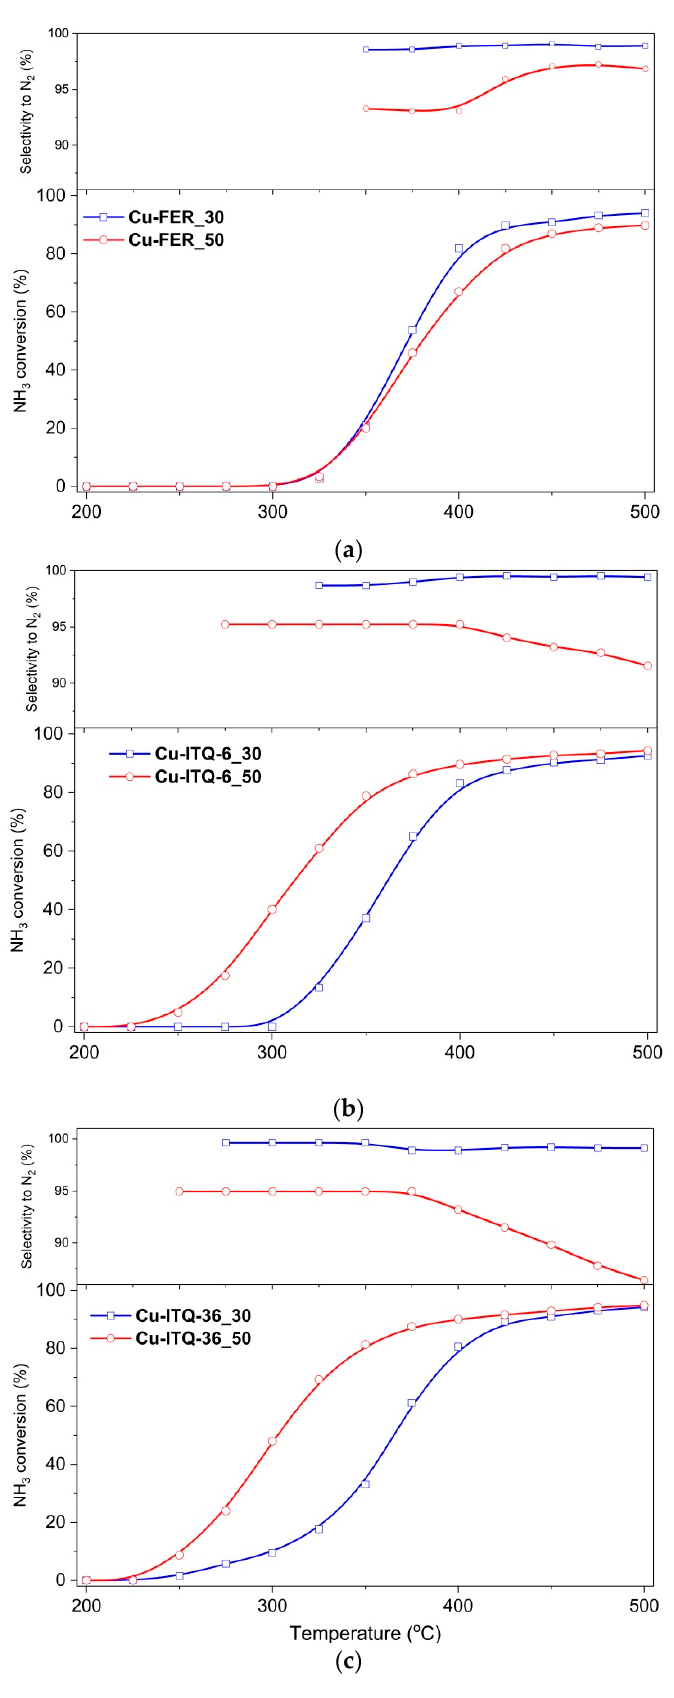
Figure 9. Results of AMOx tests for FER ( a ), ITQ-6 ( b ) and ITQ-36 ( c ) samples modified with Cu.